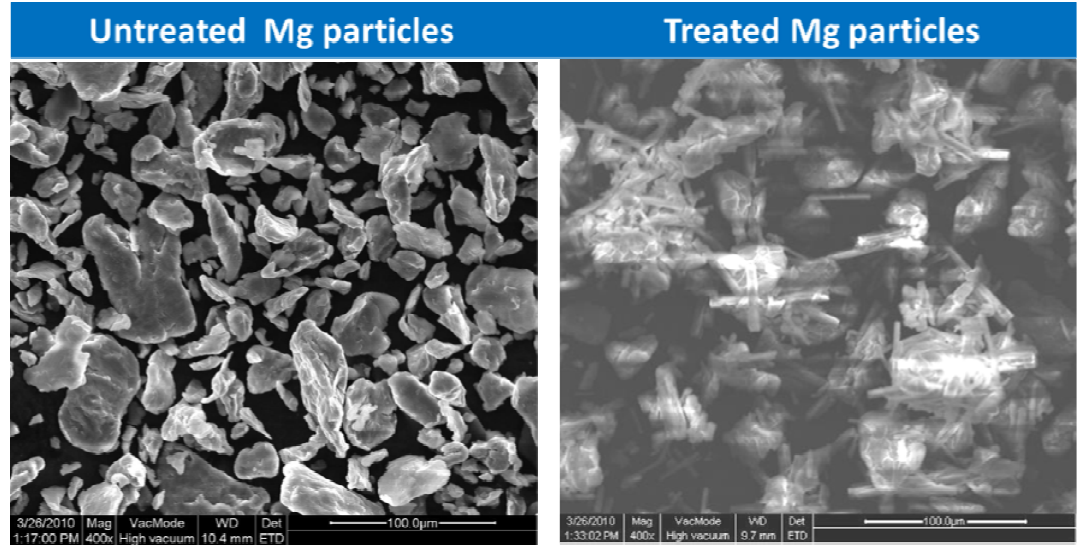
Figure 8. Treatment of Mg particles prior to coating